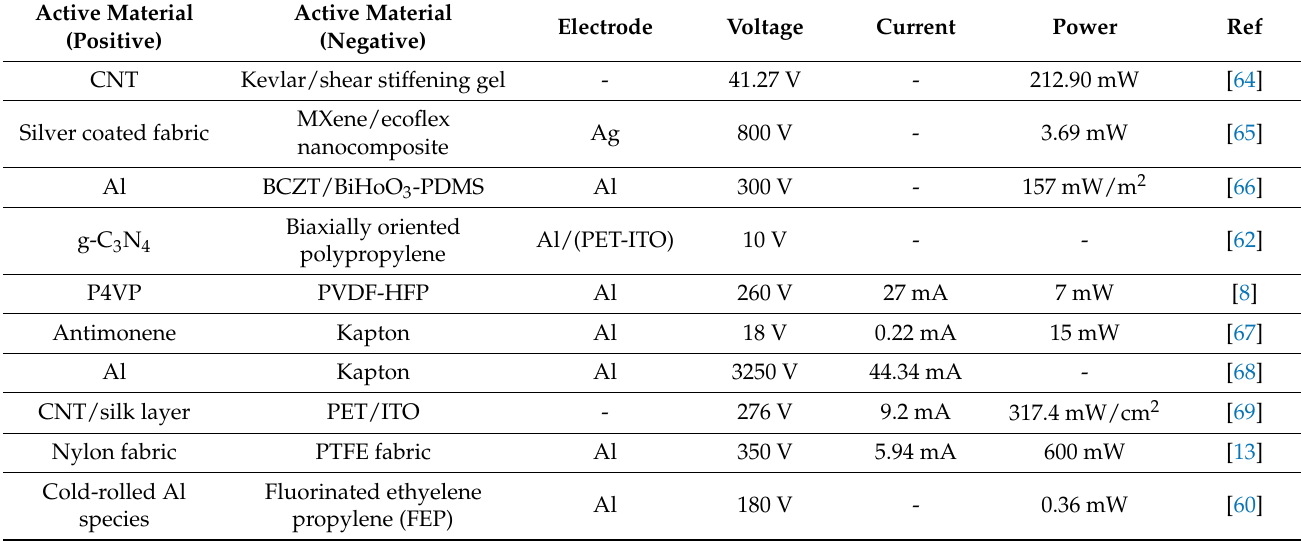
Table 2. Performance of different TENGs obtained from the combination of specific tribopositive and tribonegative materials. Active